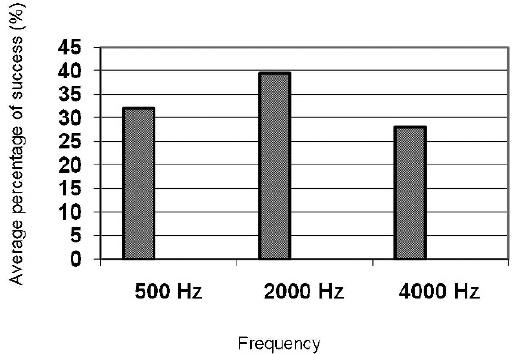
Figure 2 - A comparison of the average percentage of success (correct responses) among the frequencies.